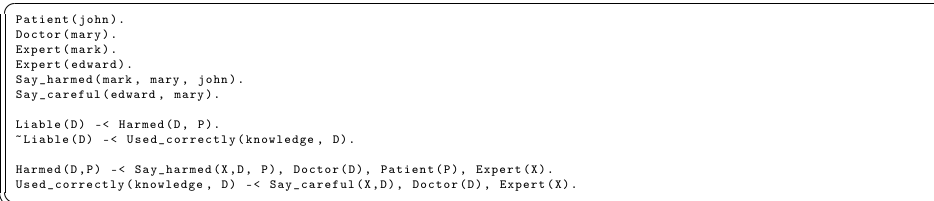
Figure 4. DeLP formalism.